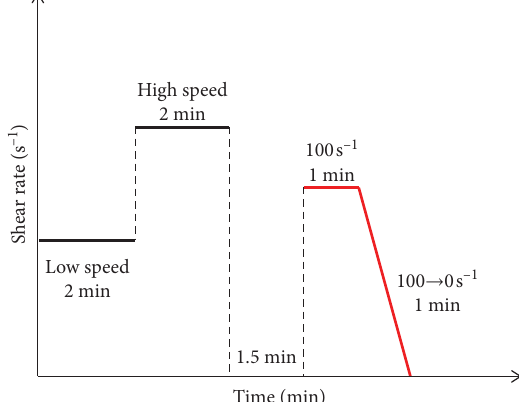
Figure 5: Flow chart of the mixing and rheological measurement sequence.